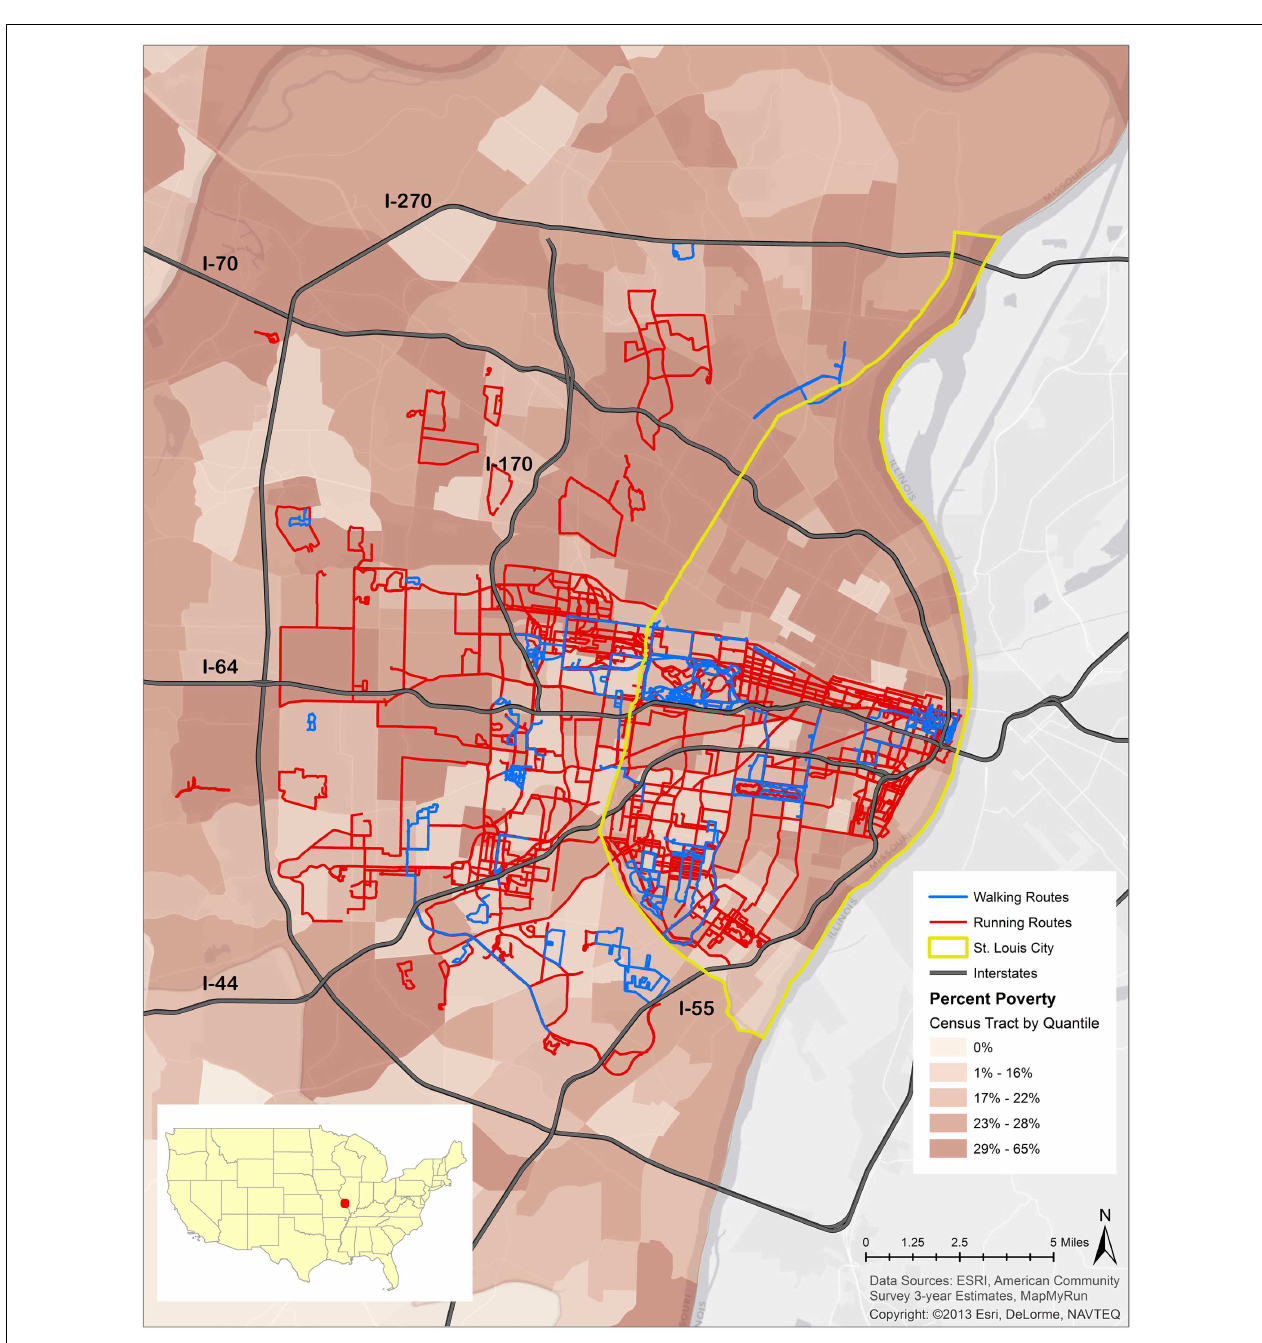
FIGURE 1 | Running routes, walking routes, and poverty rate in St. Louis, MO, USA .